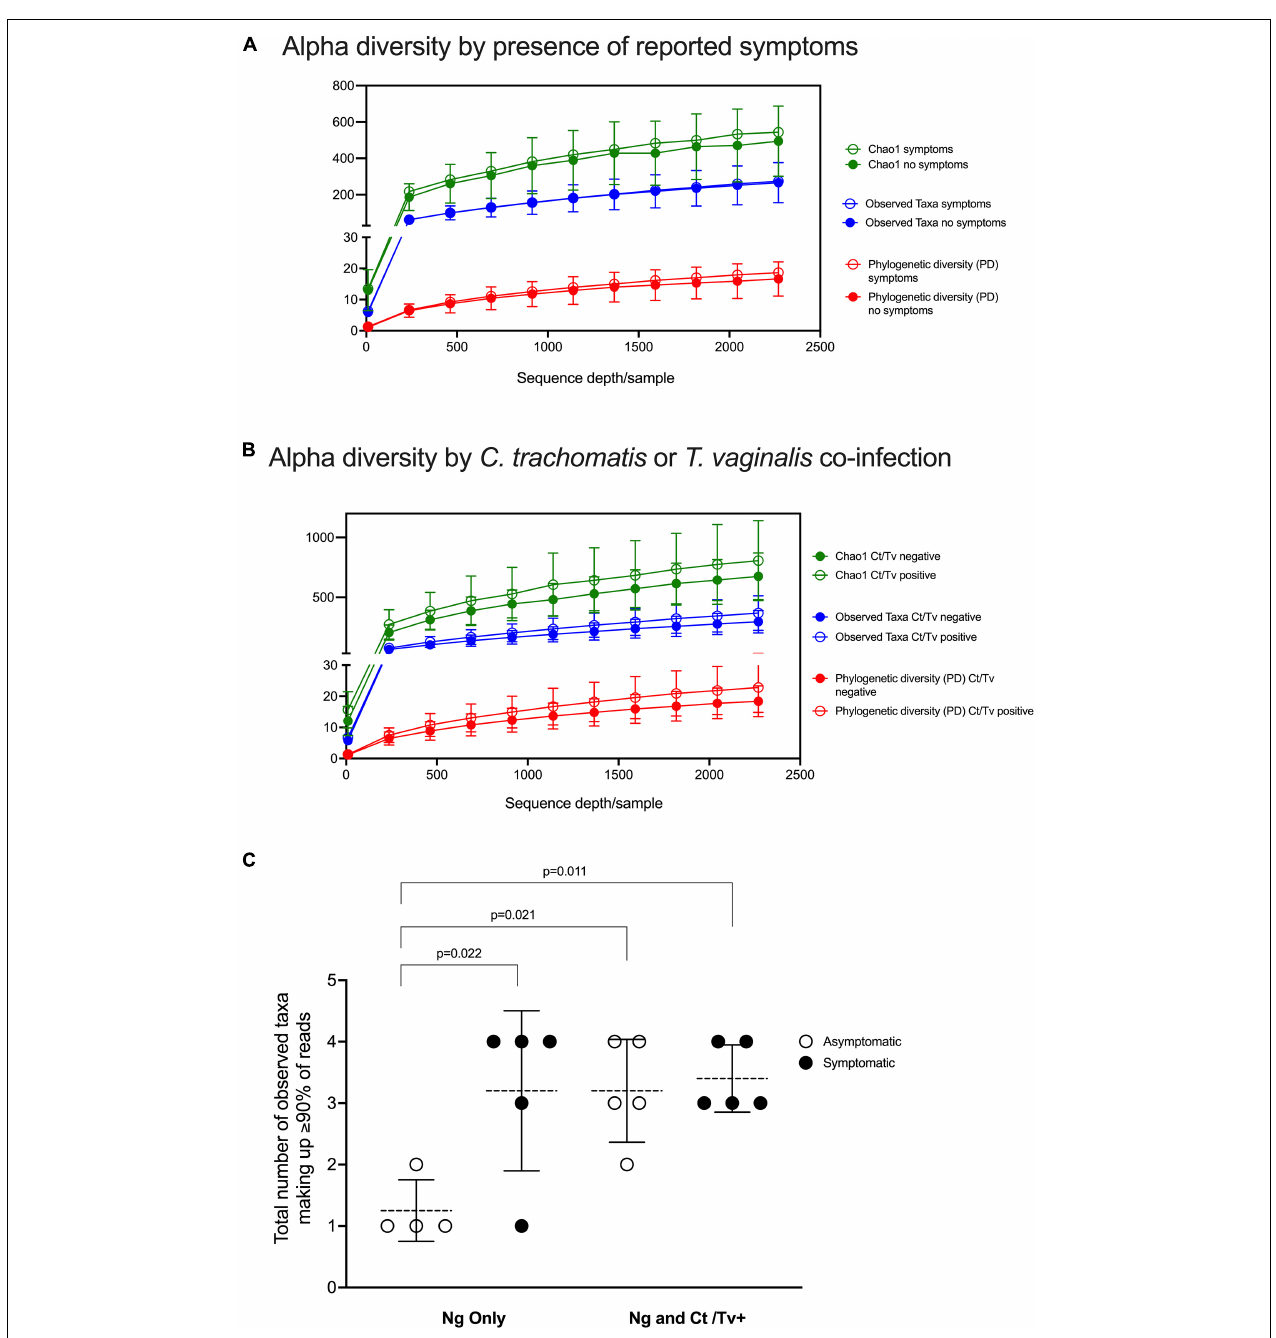
FIGURE 2 | Alpha diversity analyses with respect to clinical presentation and other STI co-infection. Alpha diversity was measured by three different metrics (Chao1; observed species; and PD, phylogenetic diversity) at a depth of 2,270 reads and visualized as rarefaction plots. Overall alpha diversity are plotted for the symptomatic and asymptomatic N. gonorrhoeae infection patient groups (A) and for the co-infection patient groups (i.e. with and without other STI) (B) . The number of dominant taxa comprising the majority of the microbial community (i.e., 90% of all detected taxa) is plotted for individuals with asymptomatic and symptomatic N. gonorrhoeae infection with and without STI co-infection (C) . Statistically significant differences between patient groups were explored with one way ANOVA with Tukey’s correction for multiple